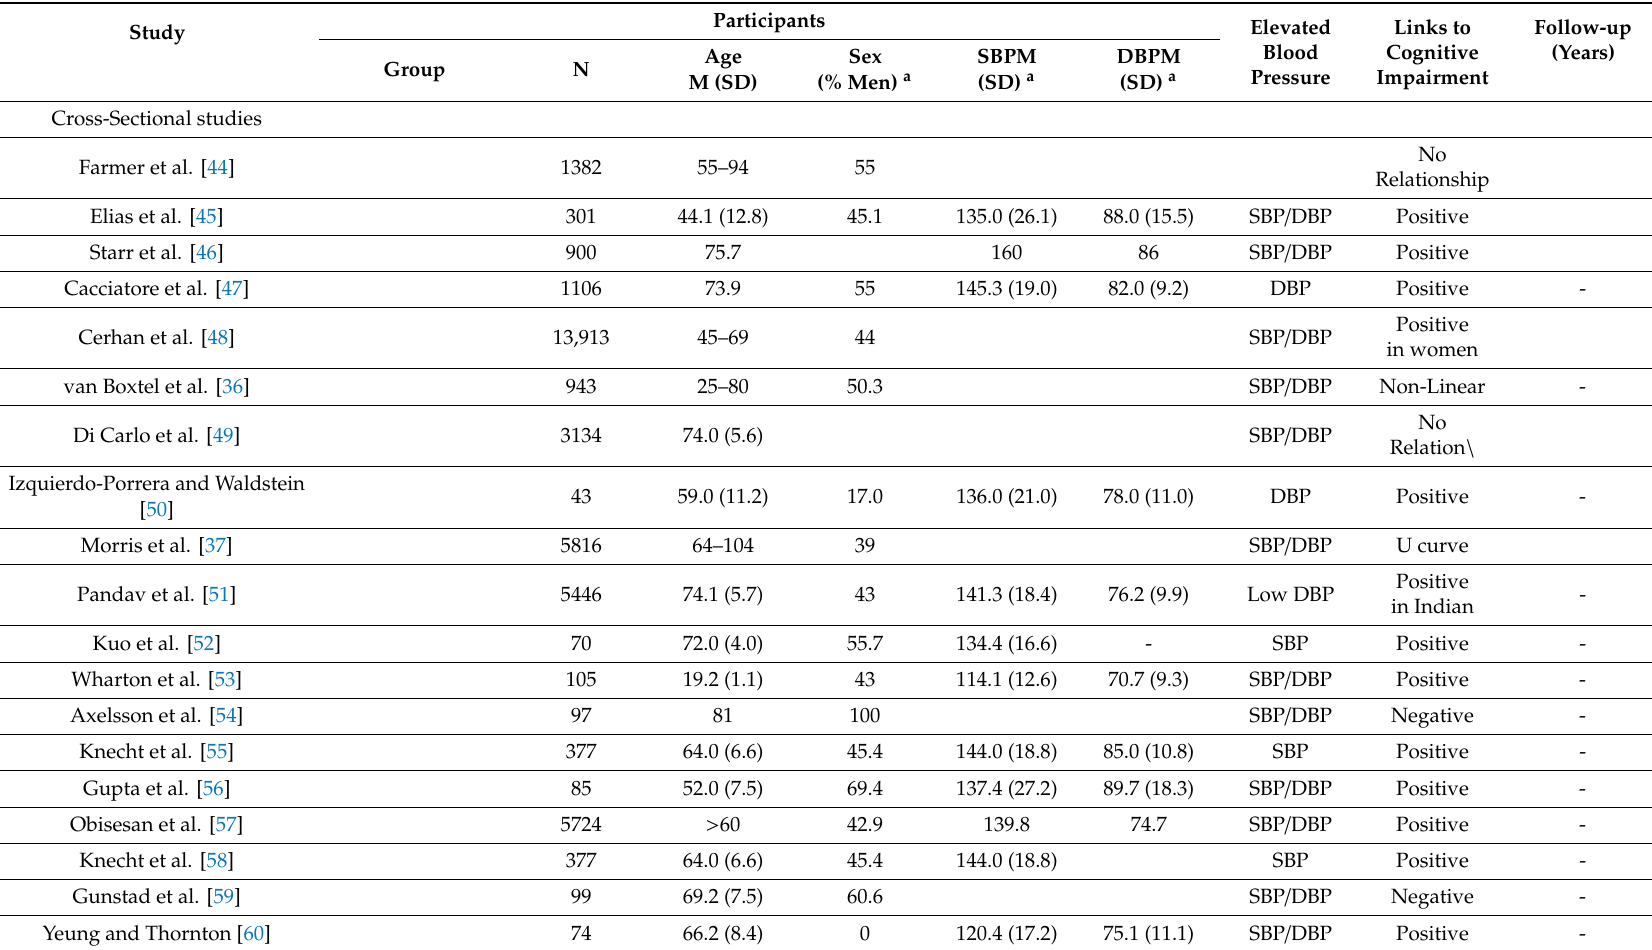
Table 2. Characteristics of the selected